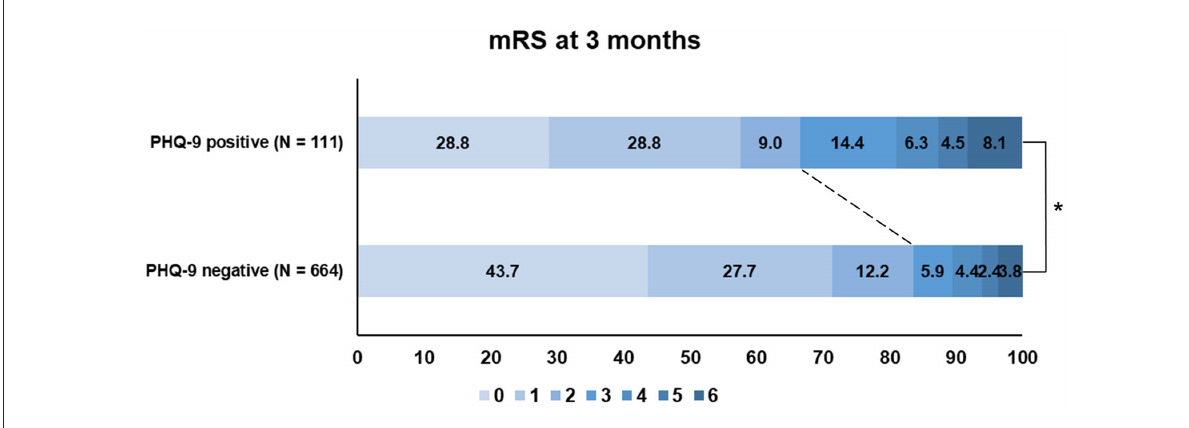
FIGURE2 Functional outcome (modified Rankin Scale) at 3 months according to the PHQ-9 status. PHQ-9, Patient Health Questionnaire-9; mRS, modified Rankin